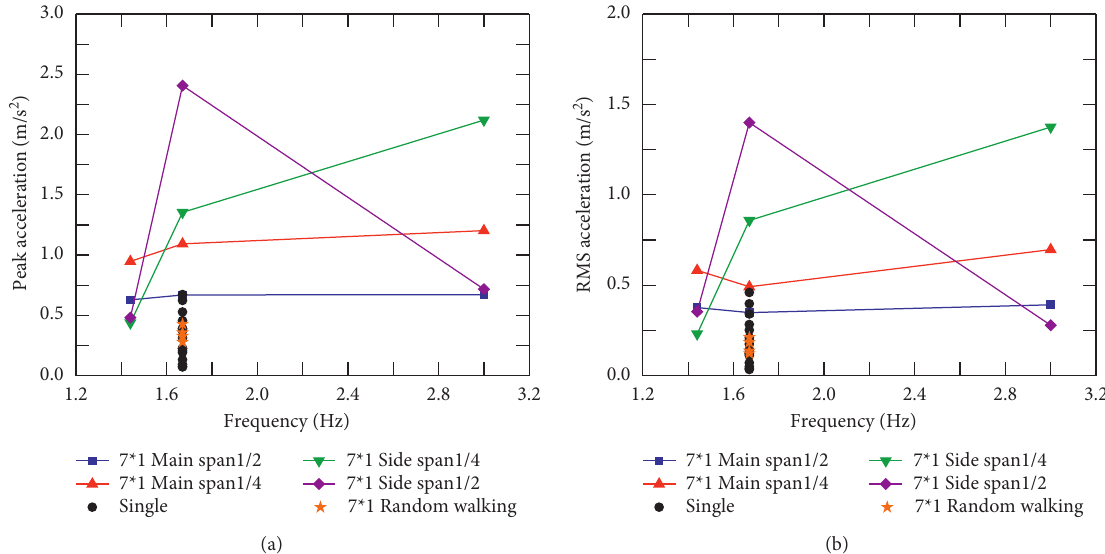
Figure 13: Correlation between bridge (a) peak acceleration, (b) 1 s RMS, and step frequency.